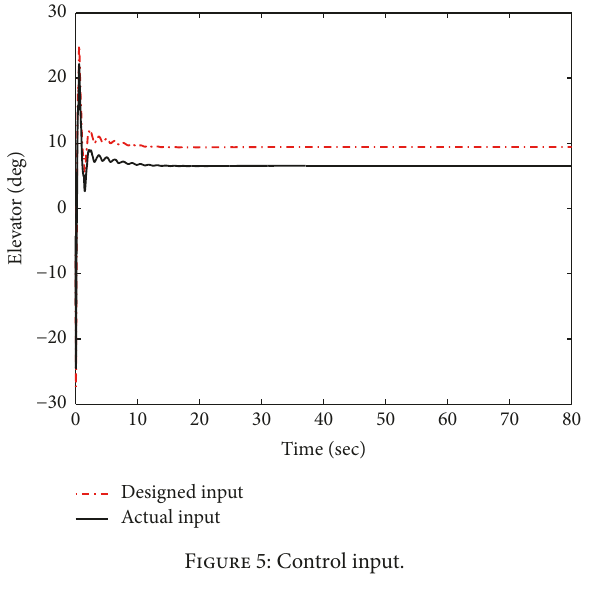
Figure 5: Control